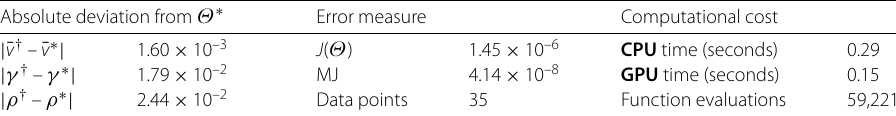
Table 7 Averaged performance of the backward pass of the Heston–CaNN, calibrating 3 parameters on a CPU (Intel i5, 3.33 GHz with cache size 4 MB) and on a GPU (NVIDIA Tesla P100), over 3125 × 5 (random seeds) test cases, where † stands for CaNN estimated value, and ∗ stands for the true value, with MJ = J ( Θ )/ N